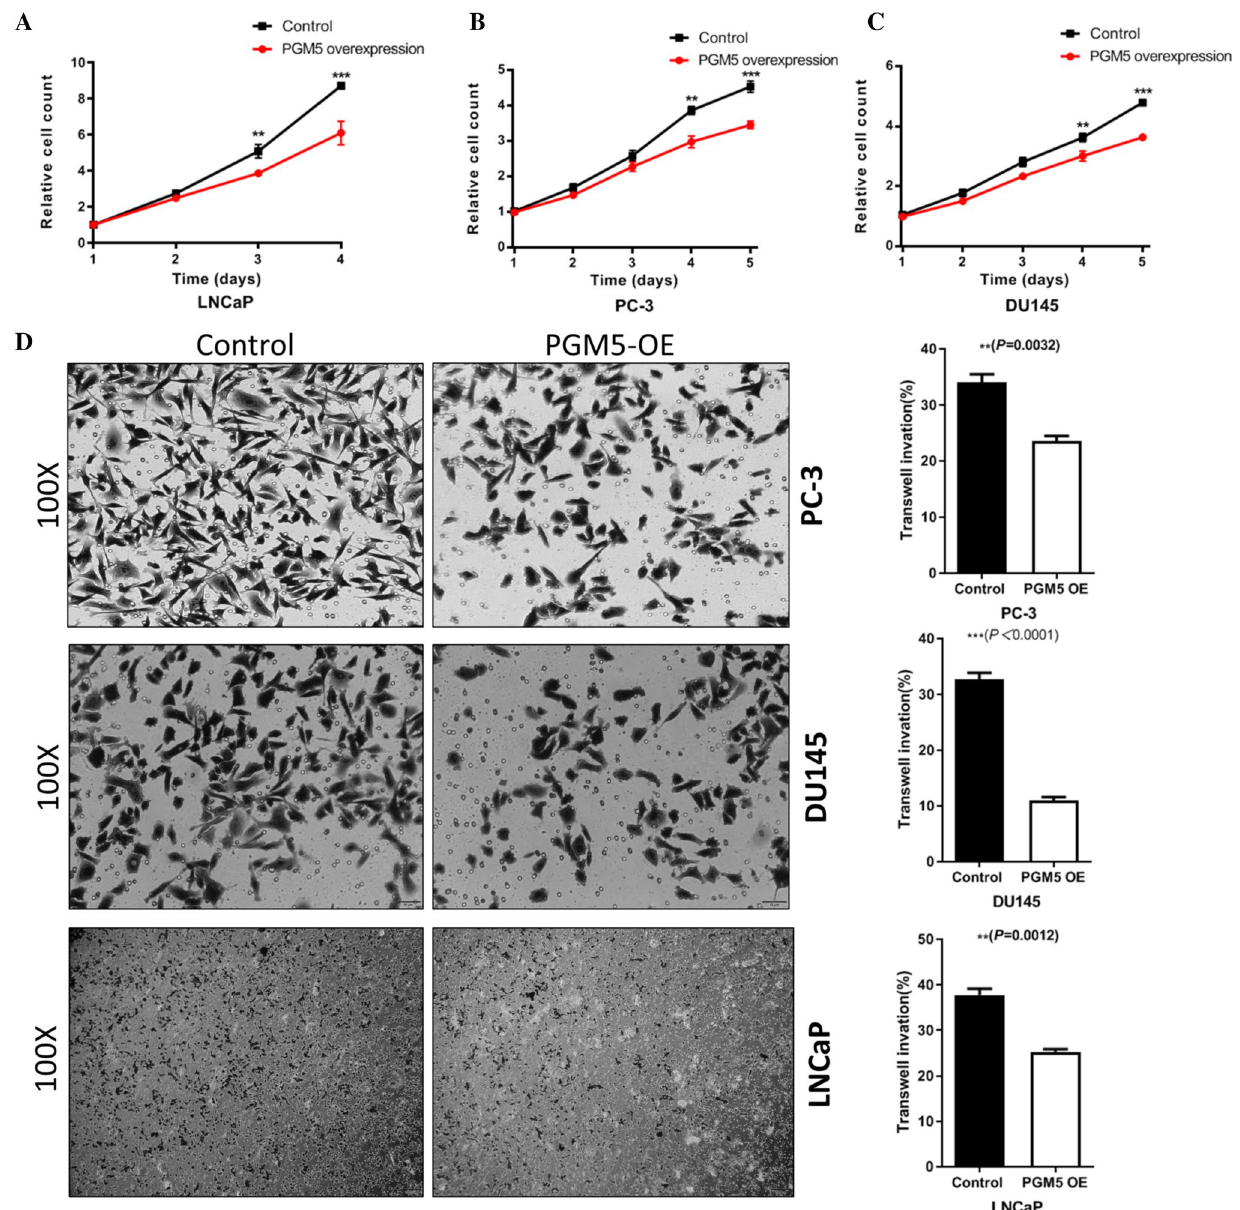
Fig. 3 PGM5 suppresses prostate cancer cell proliferation and migration. A Cell proliferation was measured at the indicated time points in LNCaP cells (** P < 0.01, *** P < 0.001, N = 3). B Cell proliferation was measured at the indicated time points in PC-3 cells (** P < 0.01, *** P < 0.001, N = 3). C Cell proliferation was measured at the indicated time points in DU145 cells (** P < 0.01, *** P < 0.001, N = 3). D Transwell assay analyses of the indicated cell lines (N =